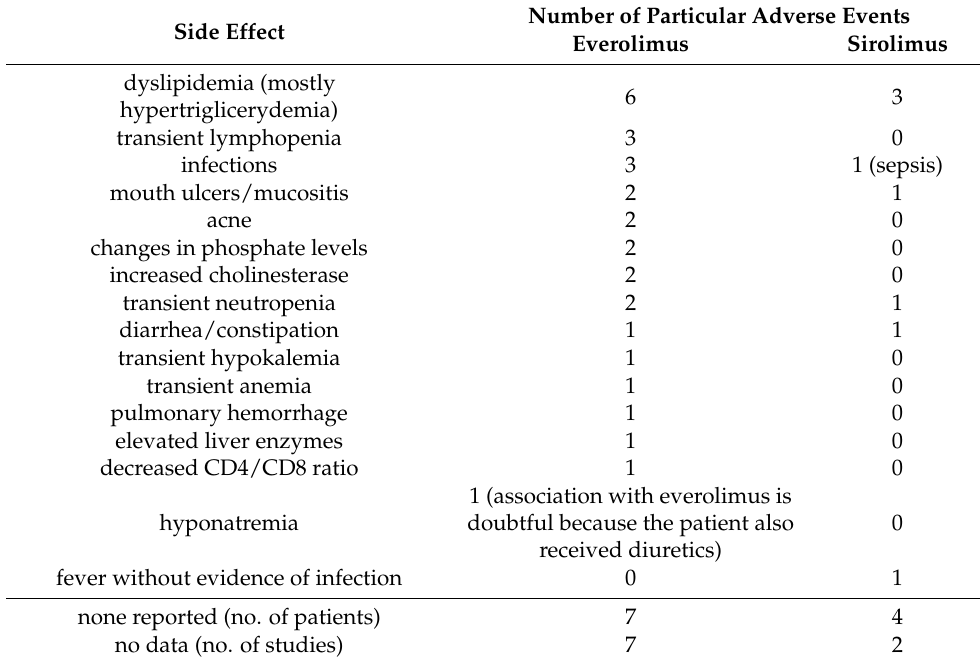
Table 3. Summary of mTOR inhibitor side